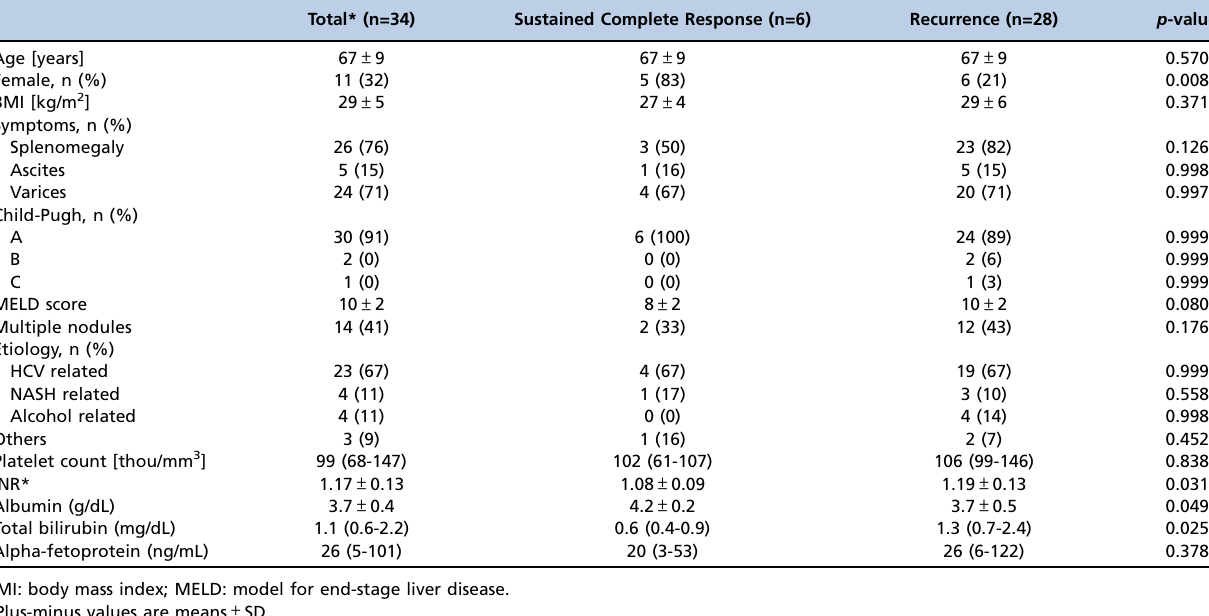
Table 2 - Patient characteristics.